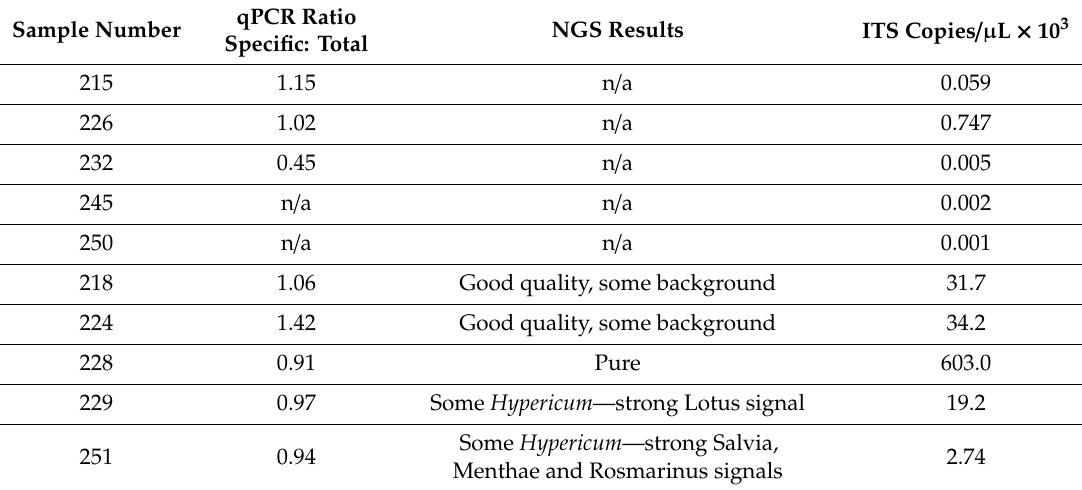
Table 6. Correlation between DNA yield and qPCR and Next Generation Sequencing (NGS) results for the ten highest quality DNA samples. The success of the specific qPCR and NGS assays is related to the number of amplifiable ITS copies in the DNA extract. The quality of the samples determined by specific qPCR assay and NGS is also